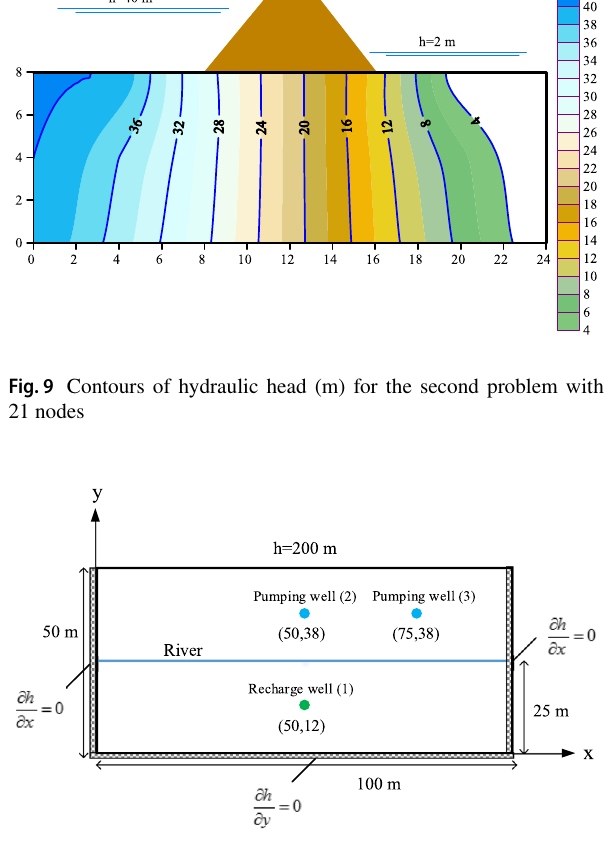
Fig. 10 Computational domain and boundary conditions for the third